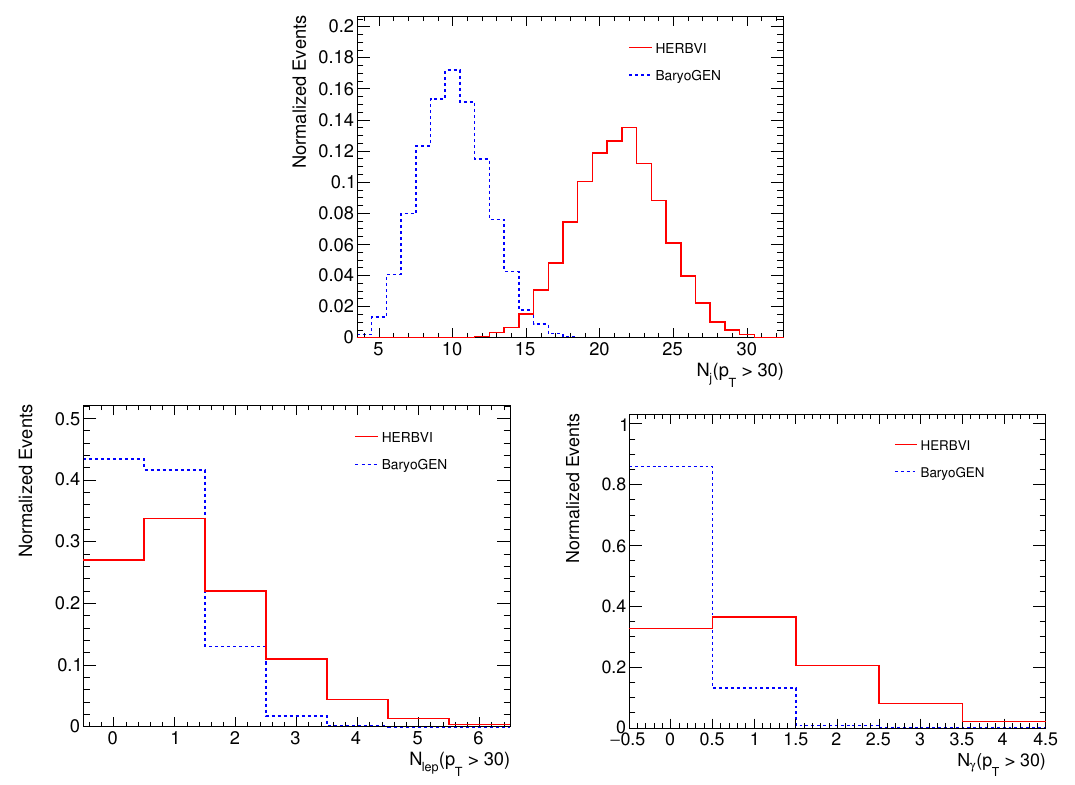
Figure 2 . The multiplicities of (cid:12)nal-state objects with p T > 30 GeV; jets (top), leptons (bottom left), photons (bottom right). The red-solid and blue-dashed histograms correspond to the multi- and zero-boson events generated by HERBVI and BaryoGEN ,